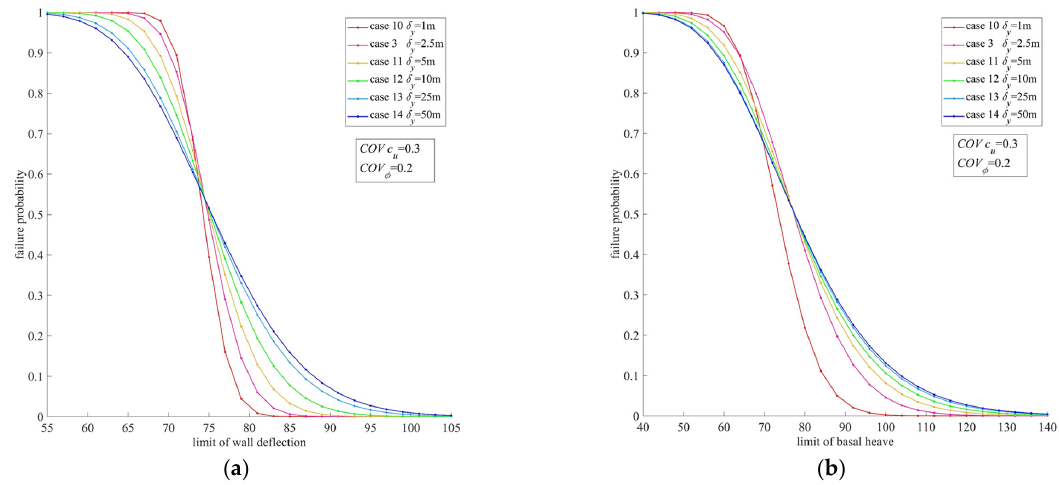
δ on failure probability at different thresholds of: ( a ) wall deflection; ( b ) basal Figure 12. Effects of y Figure 12. Effects of δ y on failure probability at different thresholds of: ( a ) wall deflection; heave. ( b ) basal